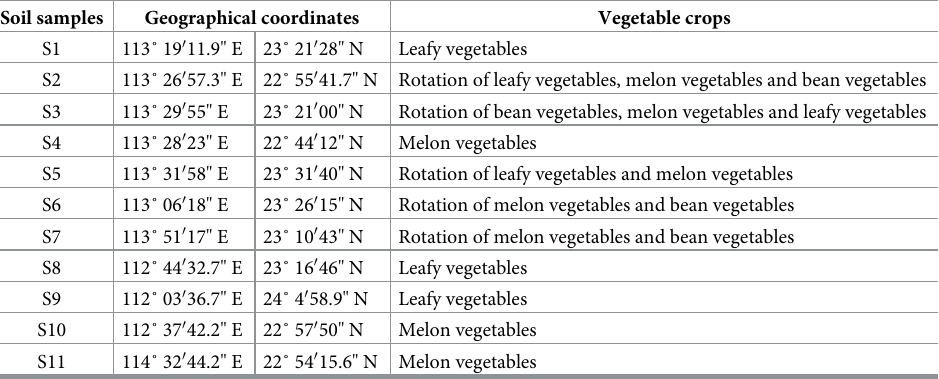
Table 1. General characteristics of the eleven samples for P adsorption isotherm experiment and soil properties analysis. Soil